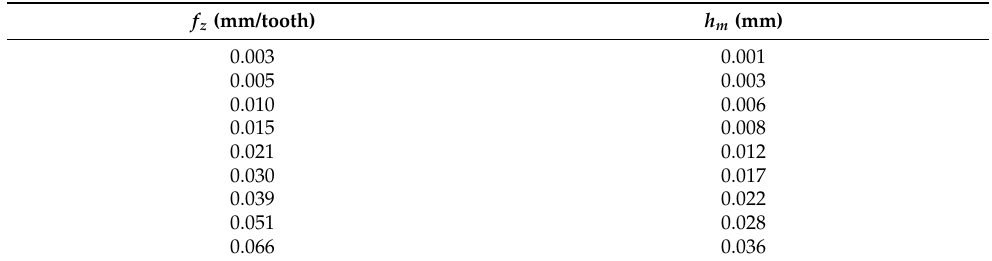
Table 5. Range of f z (in mm/tooth) and h m (in mm) considered for the determination of the mean chip thickness